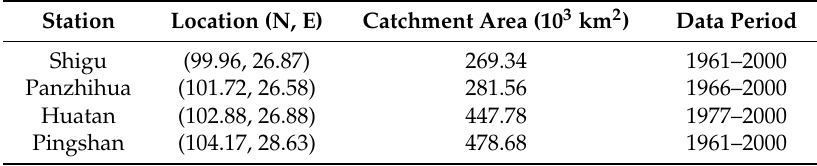
Table 2. Information of hydrological stations in the Jinsha